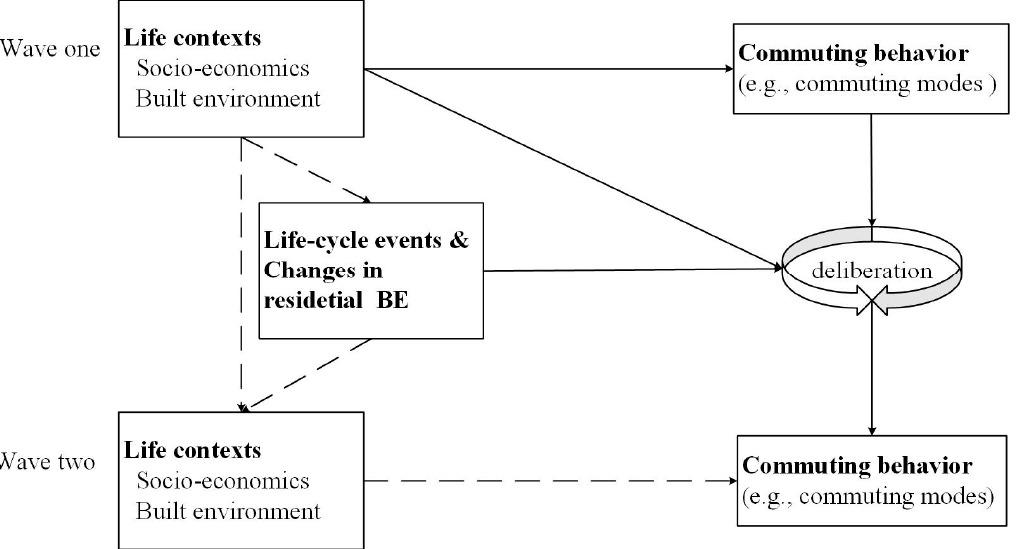
Figure 1. Conceptual framework of this